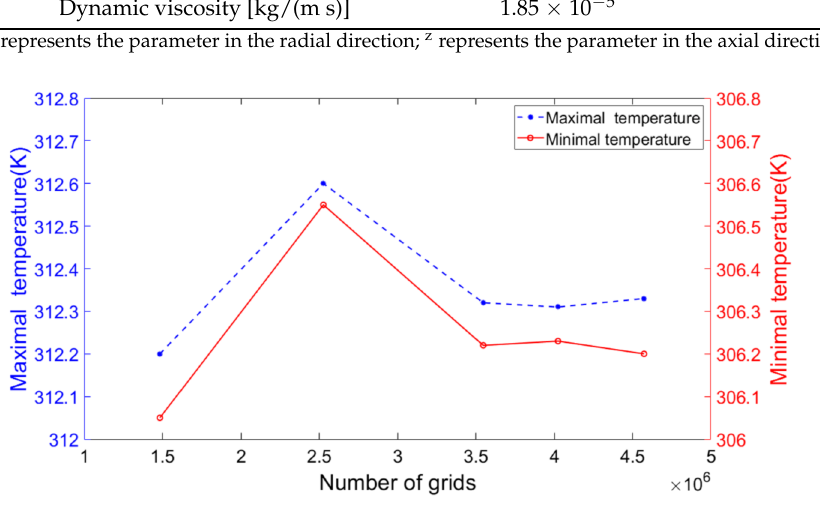
Figure 6. Result of mesh sensitivity